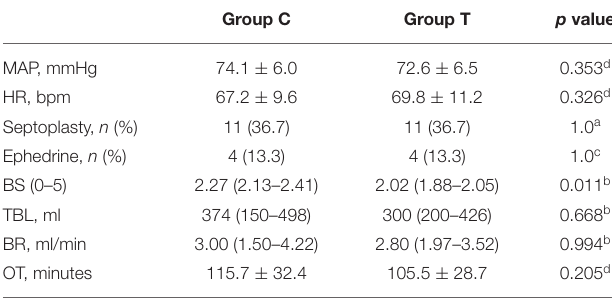
TABLE 2 | Baseline characteristics of the study patients * . TABLE 3 | Intraoperative characteristics * .